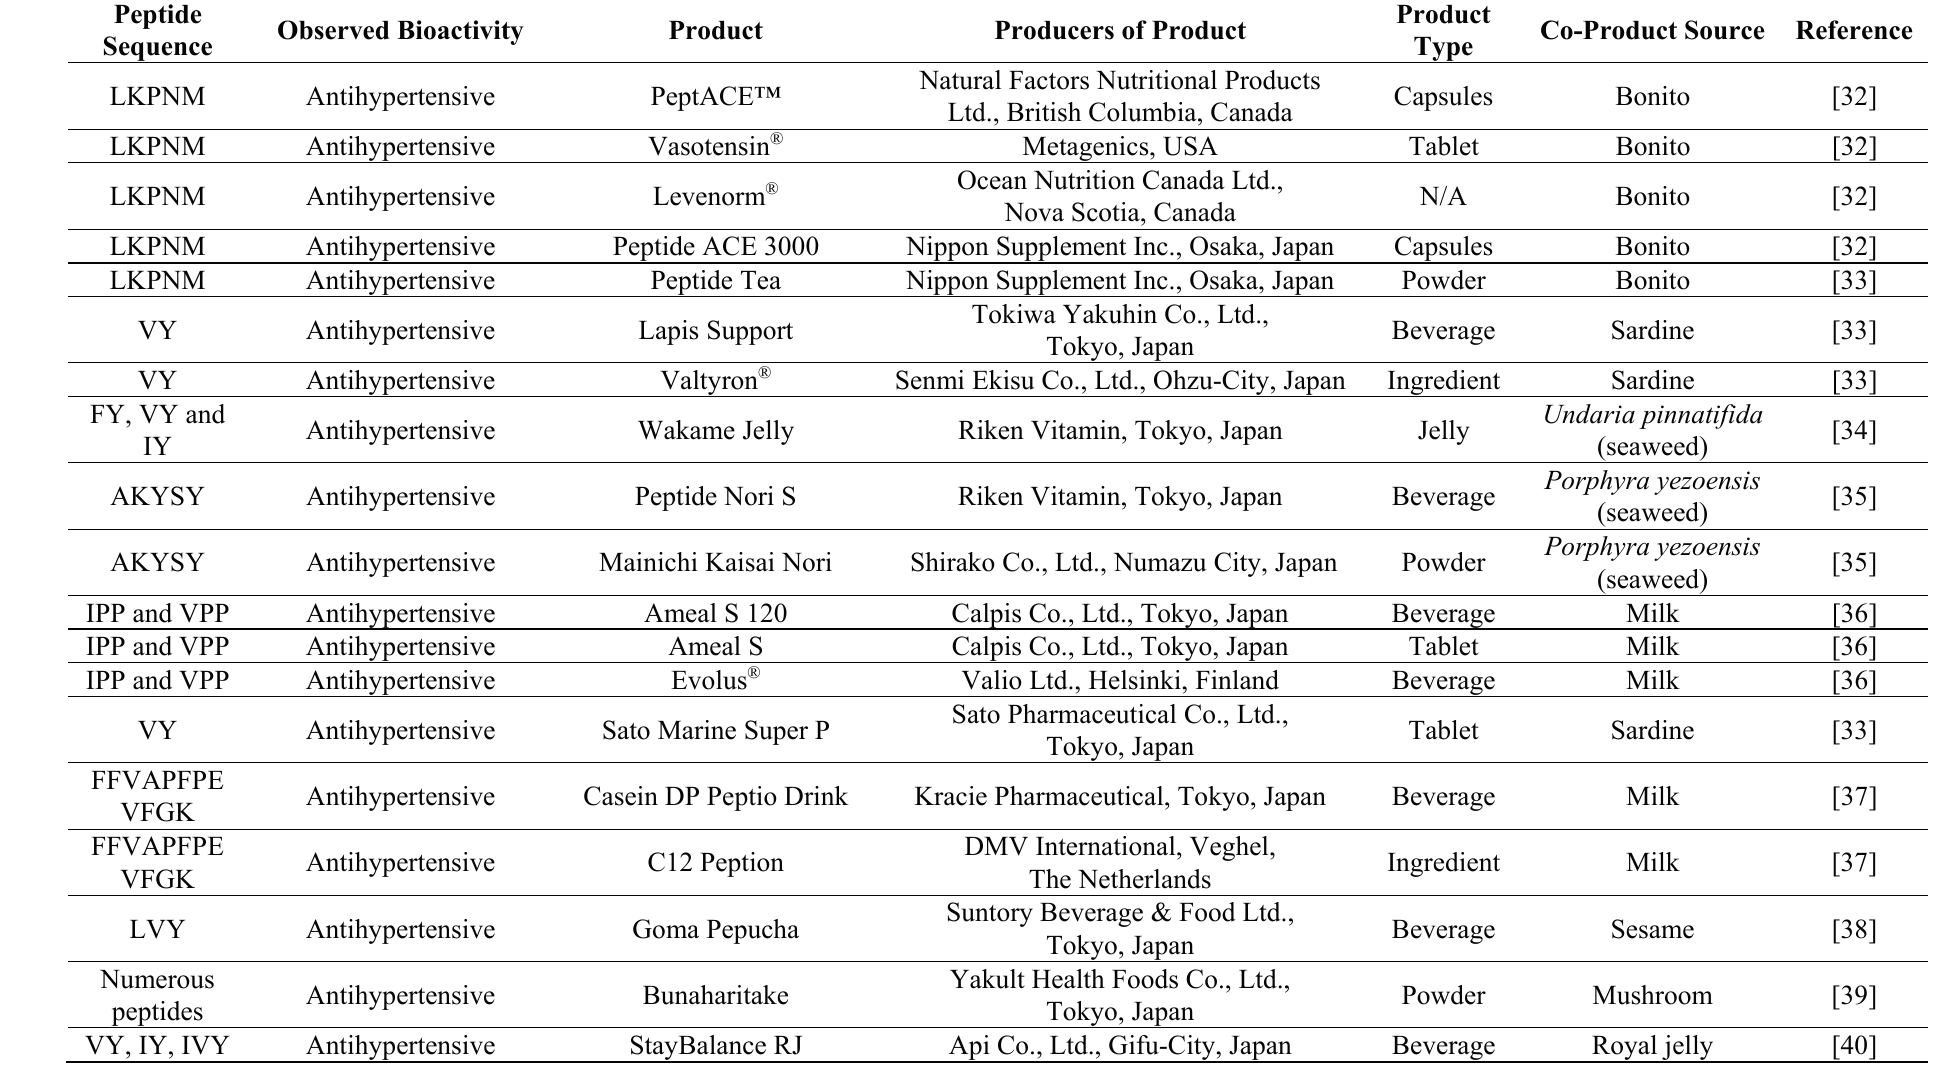
Table 1. Bioactive peptides derived from food sources and their use as bioactives in commercial